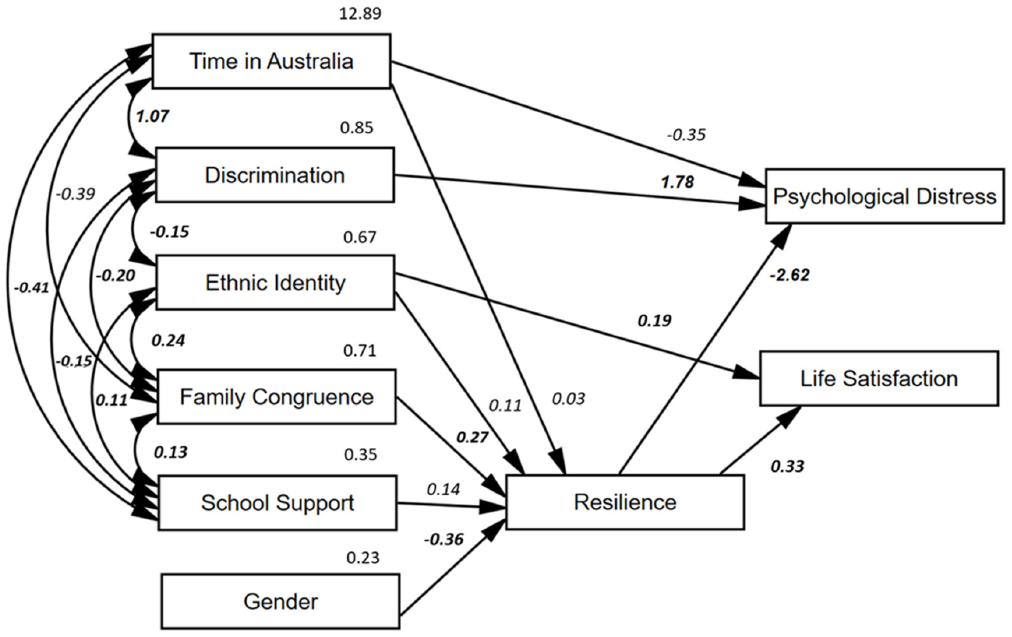
Figure 1. Mediation path model, with significant correlations and effects displayed (bold p < 0.001/not-bold p < 0.05.